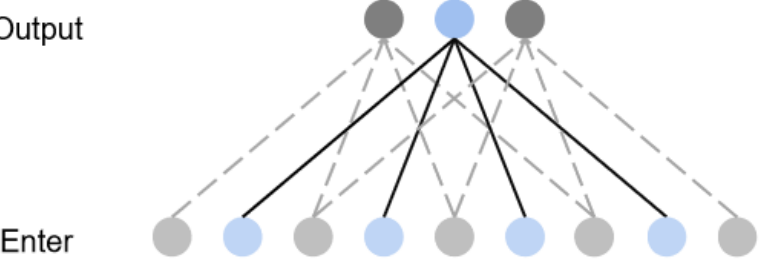
Figure 2. Dilated convolution.